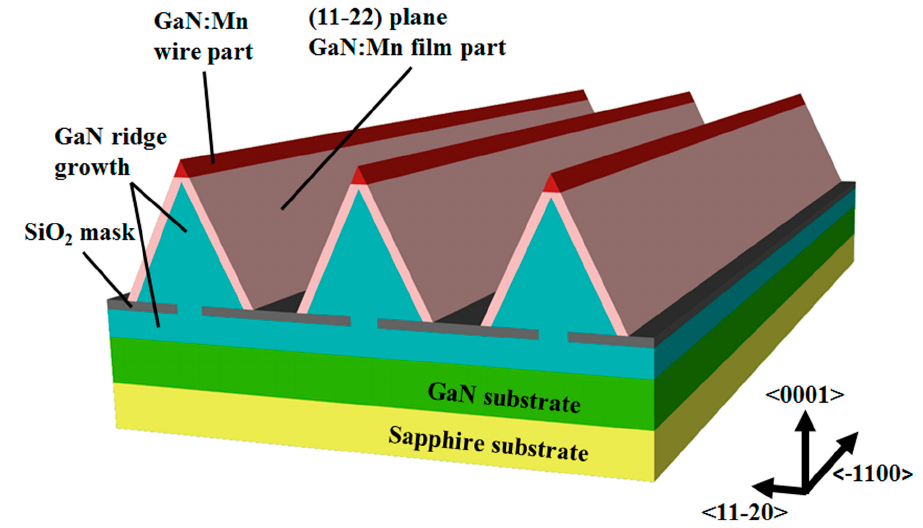
Figure 1. The schematic structure of the GaN:Mn wires grown on GaN ridges.